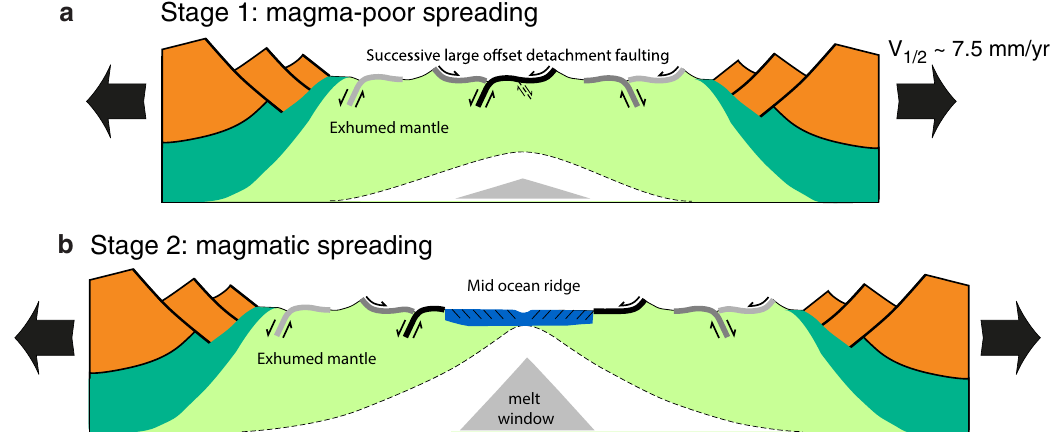
Fig. 8 Template showing main characteristics from magma-poor spreading to magmatic spreading on Galicia-Flemish Cap margins. a Phase of mantle exhumation with the successive formation of large offset detachment faults with recurrent dip reversal. b Magmatic spreading with dominant accretion of normal oceanic crust and small offset normal faults and locally formation of detachments faults and exhumed mantle domes for ultra-slow and slow